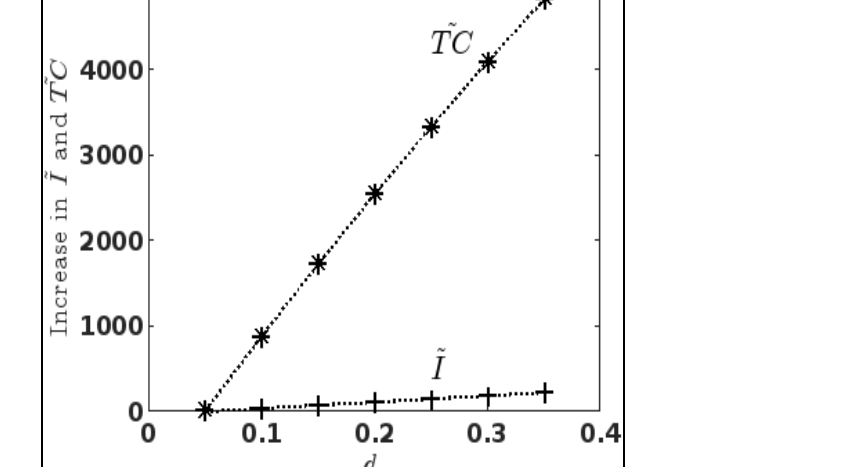
Figure 5. Effect of discount rate on purchasing cost when optimizing the total cost and ordering quantity.